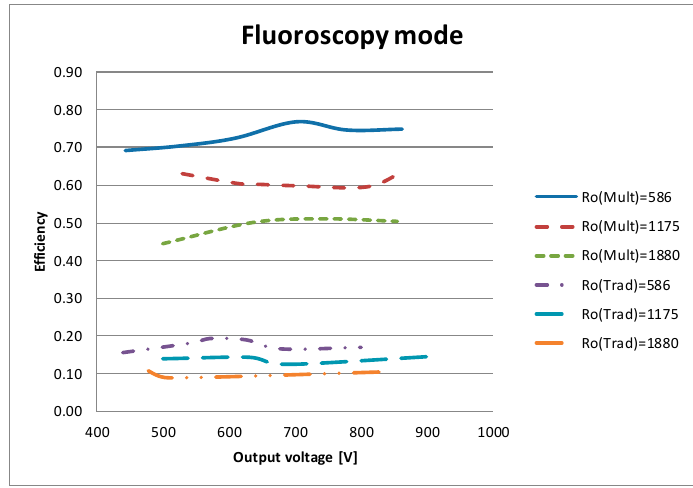
Energies 2017 , 10 , 1573